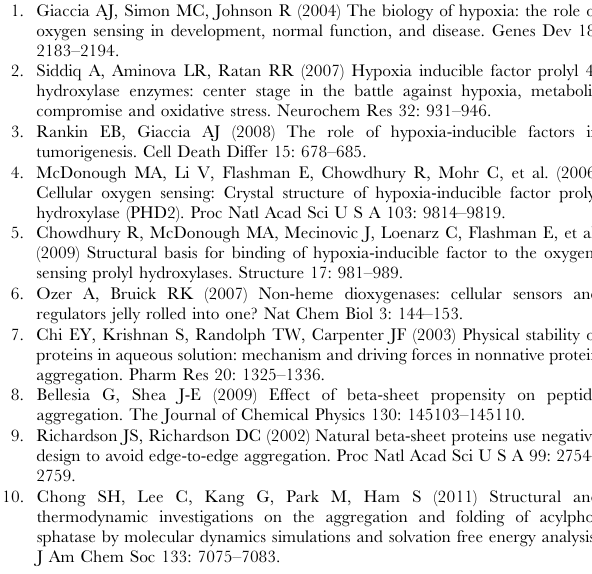
Figure S5 The animated GIF file shows the fate of Fe atom upon fh-PHD2 unfolding. The Fe atom is mentioned by yellow sphere. The red surface represents active site lumen. Table S1 The metrics used to construct the d metric is represented for a-PHD2. Table S2 The metrics used to construct the d metric is represented for f-PHD2. Table S3 The metrics used to construct the d metric is represented for fh-PHD2. Table S4 The details of structural properties for the states that determined by using affinity propagation clustering, tabulated. The reported values are the average of the fraction of unfolding that computed for the state’s members. Table S5 The details of structural properties for the states that determined by using affinity propagation clustering, tabulated. The reported values are the average of properties (real observed values) for the state’s members. Table S6 The standard error of mean for the average values that reported in Table